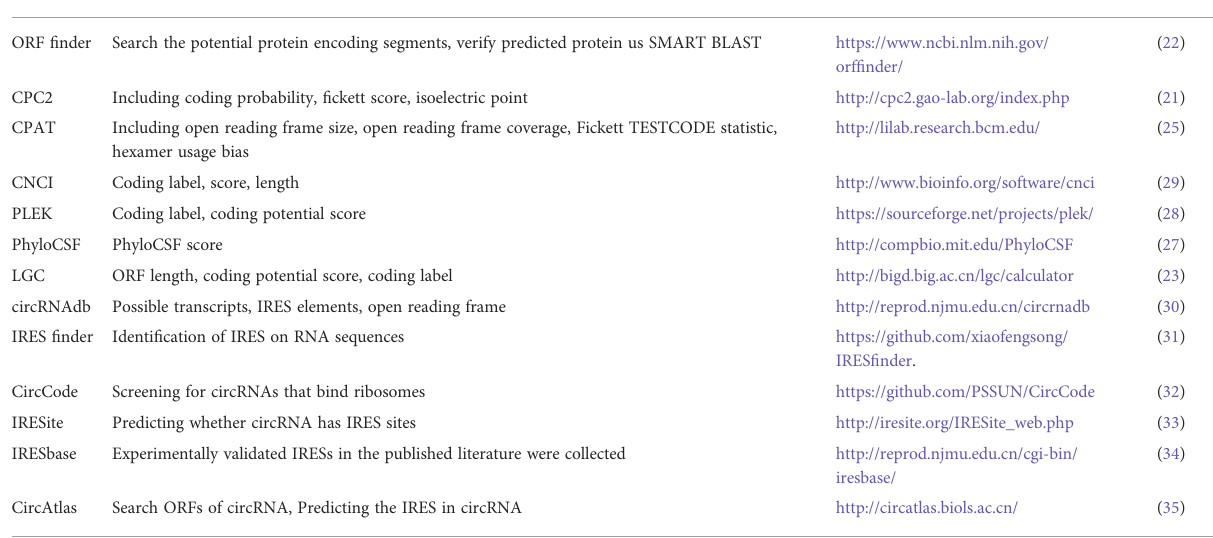
TABLE 1 Databases for ncRNAs prediction of coding